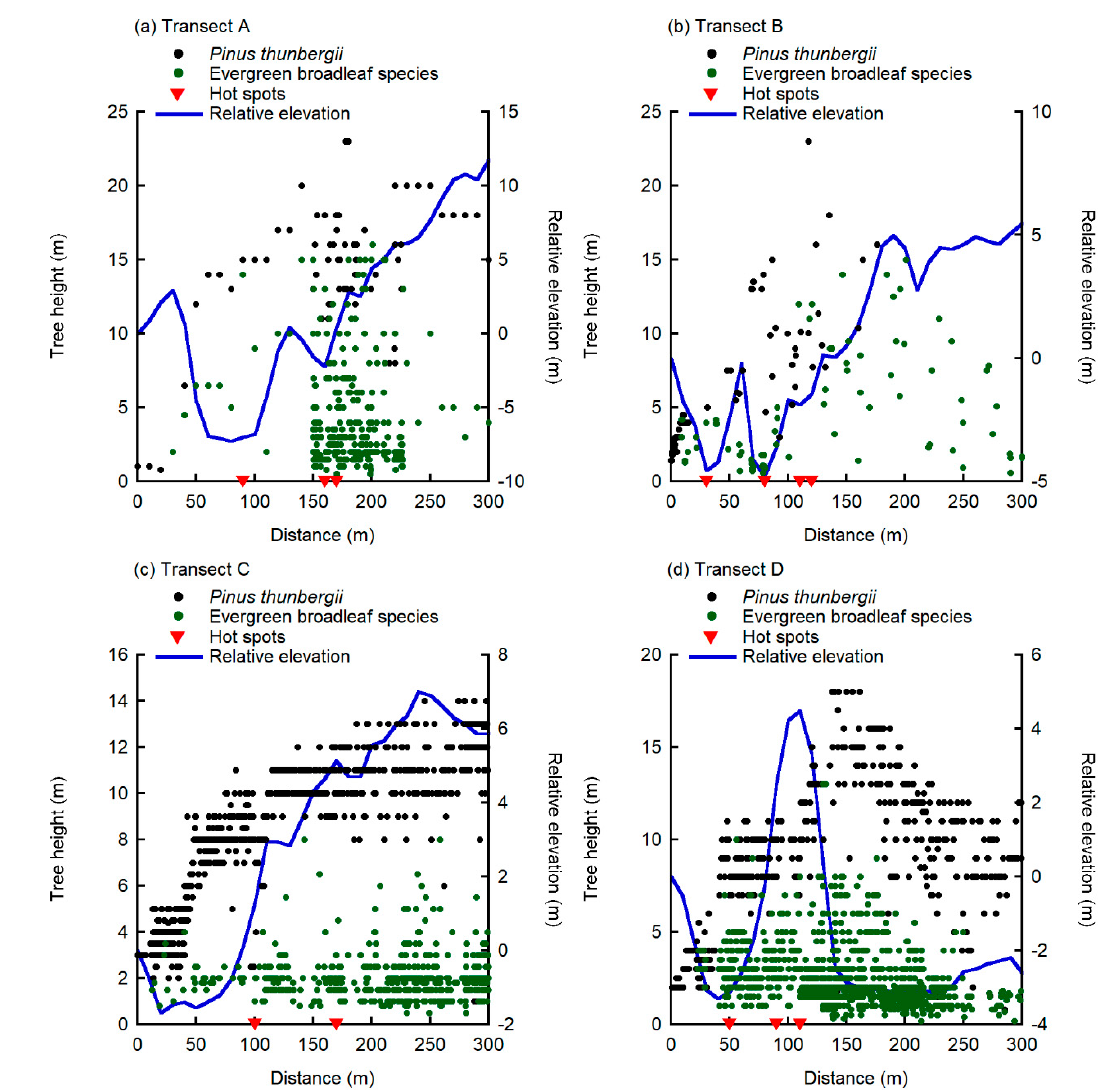
Figure 2. Ground surface elevation relative to the original point of each transect line, tree heights of Pinus thunbergii (black circles), and broadleaved trees (green circles) in transects A, B, C, and D (width 10 m) in the Sanri-Matsubara Forest, northern Kyushu, Japan. Whole individuals of tree height > 0.5 m are shown in 150–230 m section of transect A and 0-300 m section of transect C and D. Trees with canopy over precipitation collector (located 10 m intervals from the original point of each transect) are shown in 0-150 and 230-300 m section of transect A and 0-300 m section of transect B. Hot spots of sea salt deposition (see text) are shown as red inverted triangles.